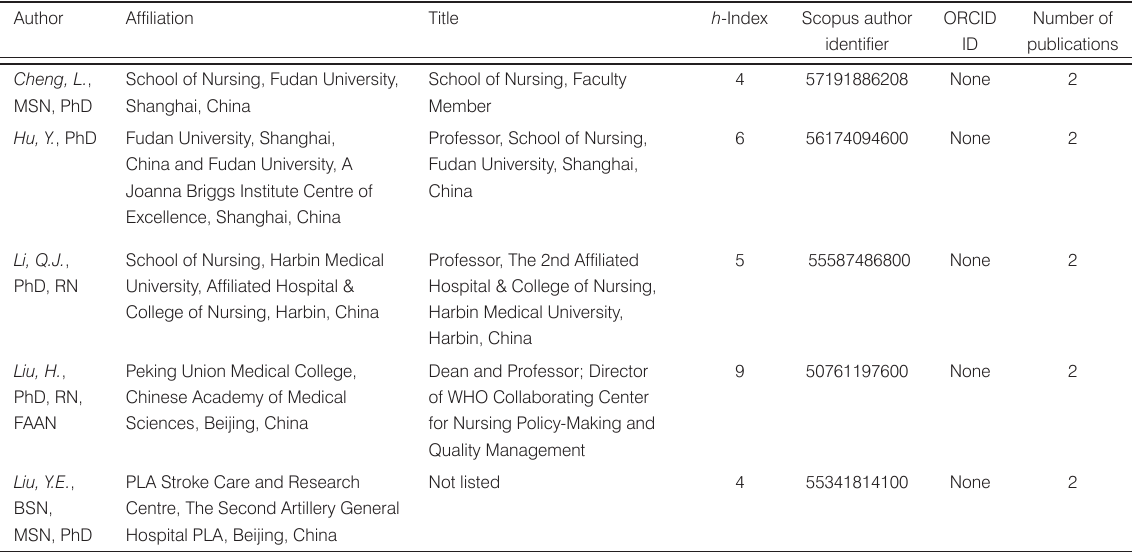
Table 5. A selection of five authors from China who published most frequently in the Journal of Nursing Management since 1993 (Scopus